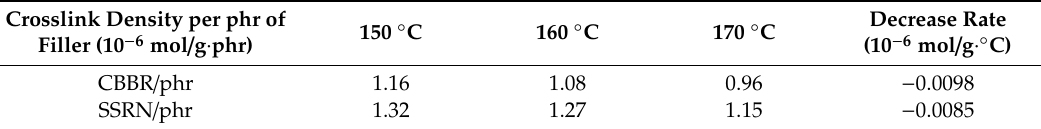
Table 5. Crosslink density per one phr of filler by di ff erent cure